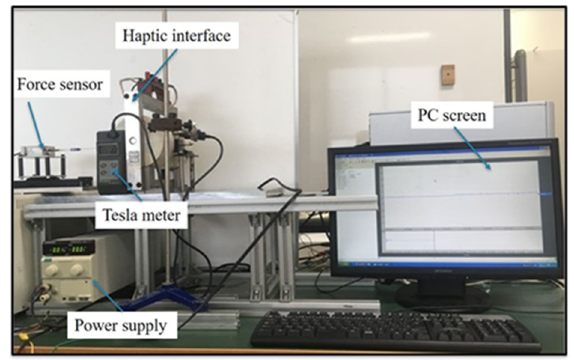
Figure 6. The experimental setup for the haptic force assessment.